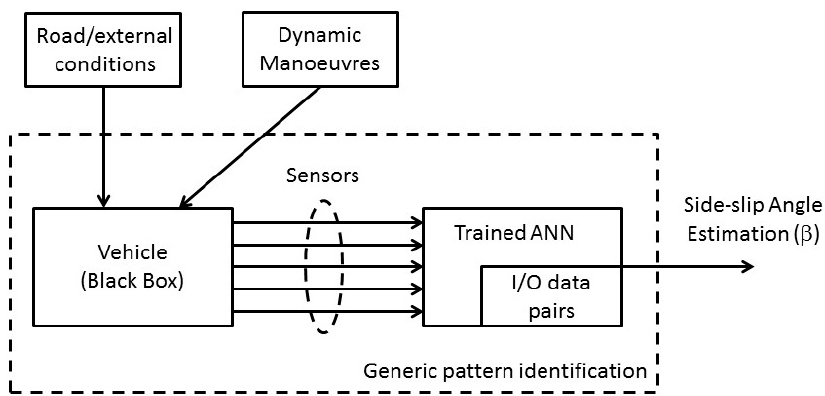
Figure 3. Artificial neural networks (ANN) estimation process high-level schematic.